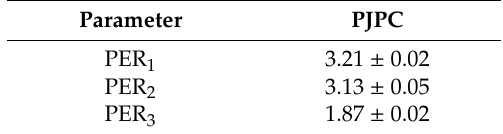
Table 3. Calculated protein e ffi ciency ratio (PER) values of